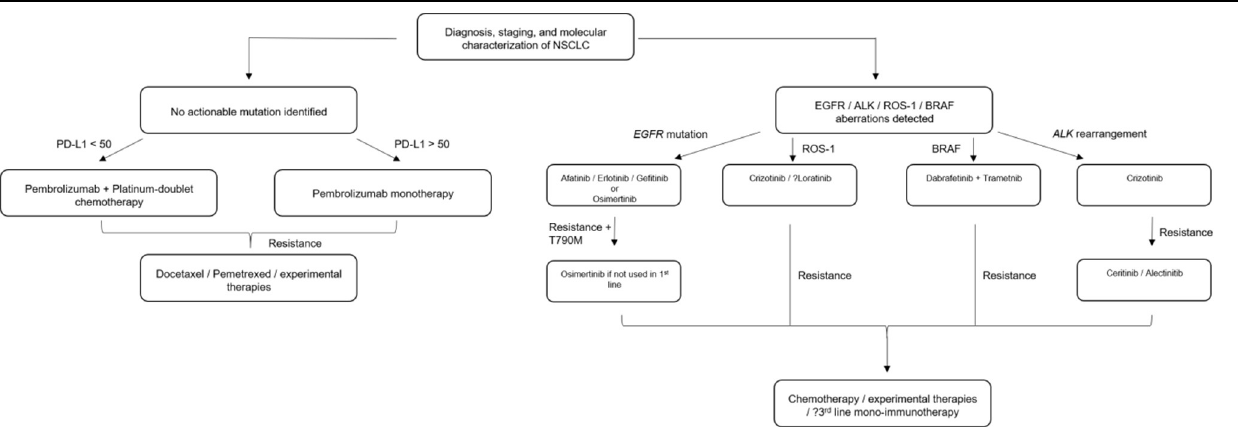
Figure 1 . Treatment Algorithm for Advanced